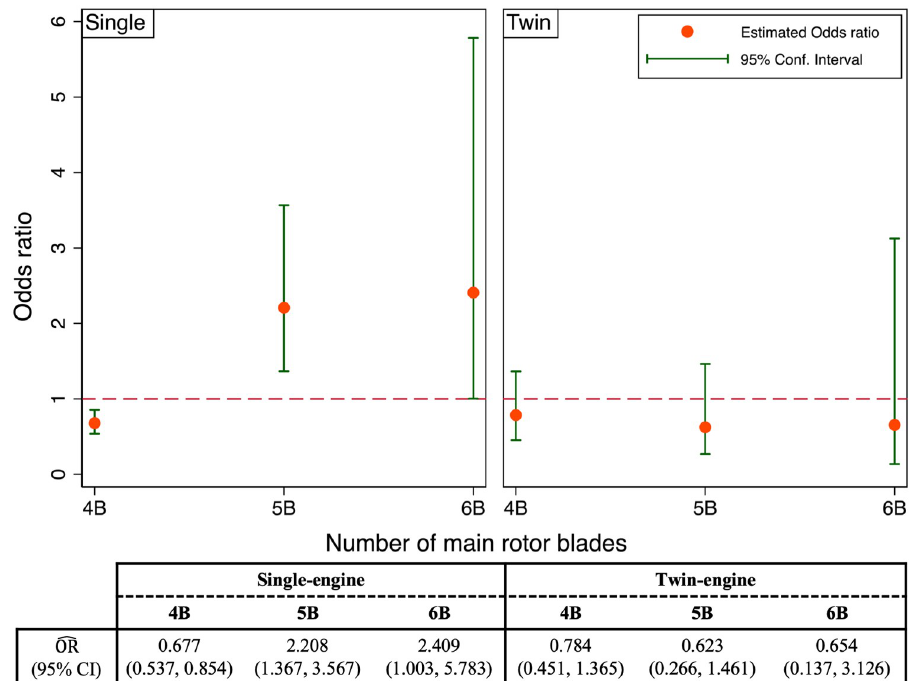
Fig 3. The estimated odds ratio for 4B, 5B, and 6B versus 2B-and-3B turboshaft helicopters.